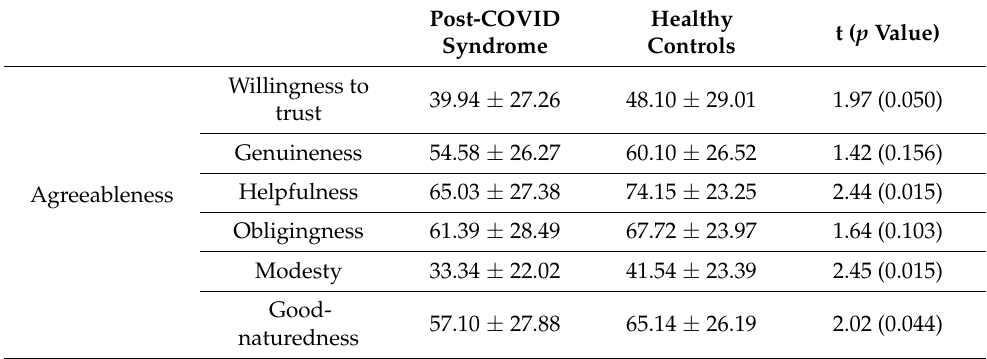
Table 3. Comparison of Big Five personality traits subfactors between patients with post-COVID syndrome and